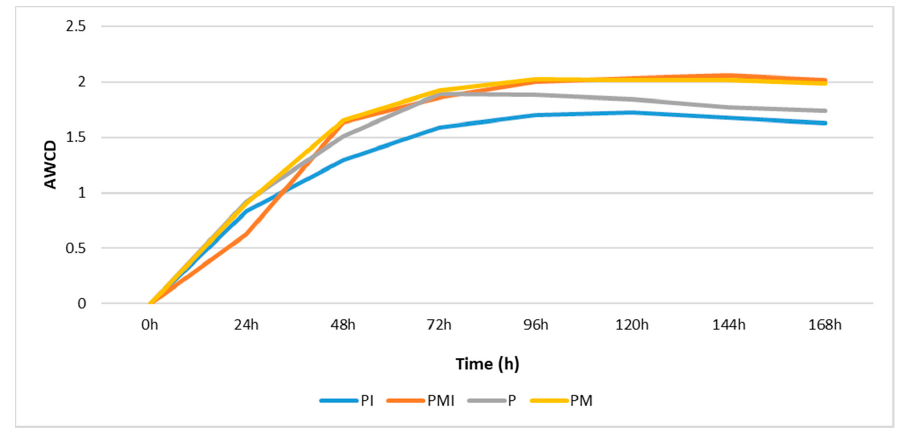
Figure 3. Average well color development (AWCD) estimated by substrate utilization over the period from 24 to 168 h in Biolog EcoPlates calculated based on the data from all 31 carbon sources.